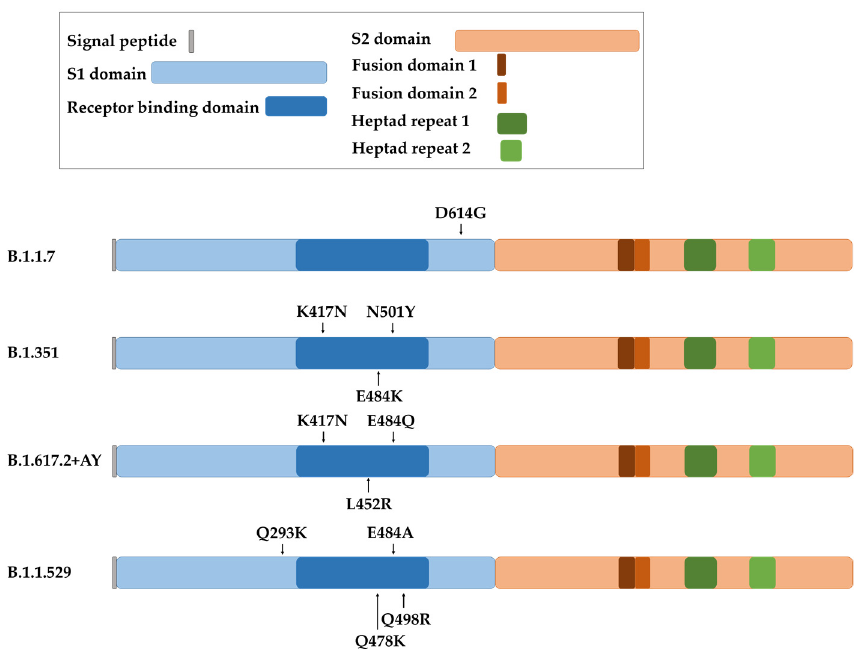
Figure 4. Representation of the spike protein of SARS-CoV-2 with the indicated domains and the localization of the main mutations involved in increased virus transmission for each variant (B.1.1.7 or Alpha variant, B.1.351 or Beta variant, B.1.617.2 + AY or Delta plus variant, and B.1.1.529 or Omicron variant).